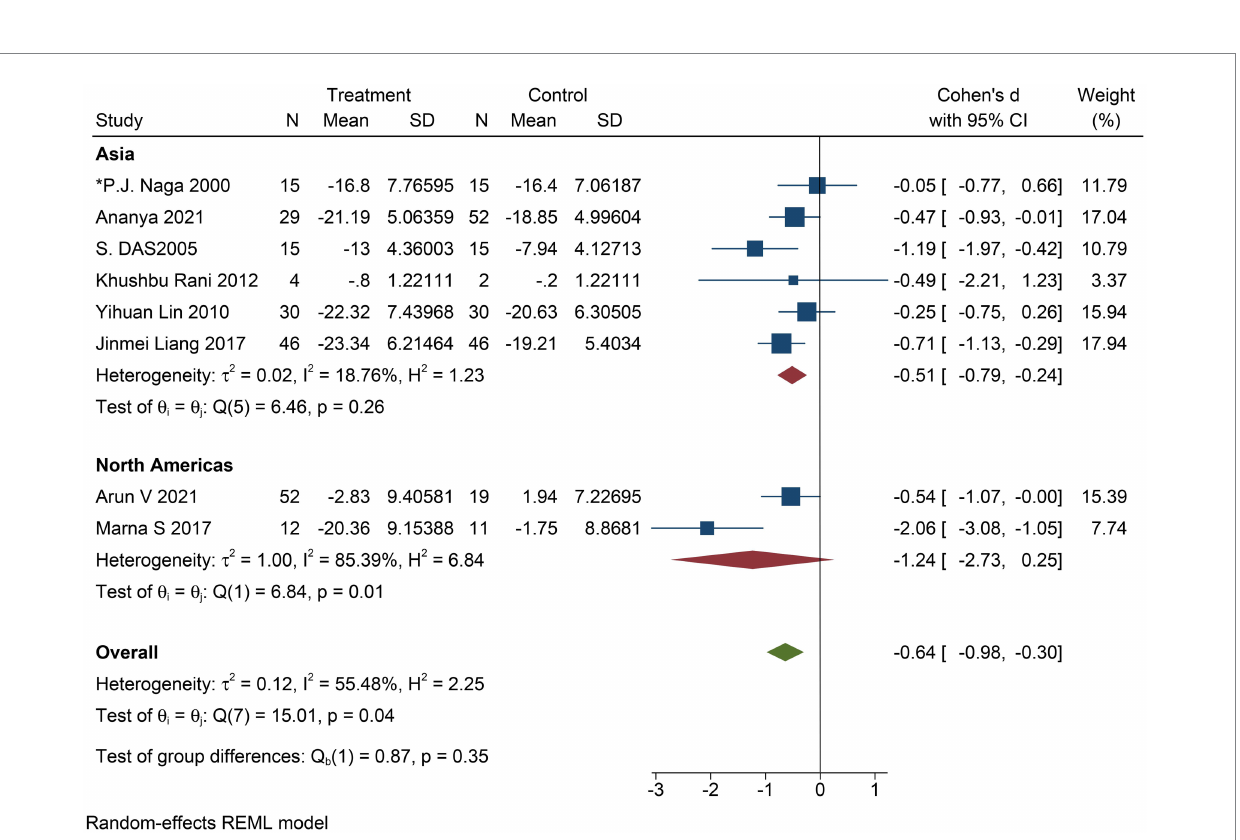
FIGURE 9 Forest plot of quality of